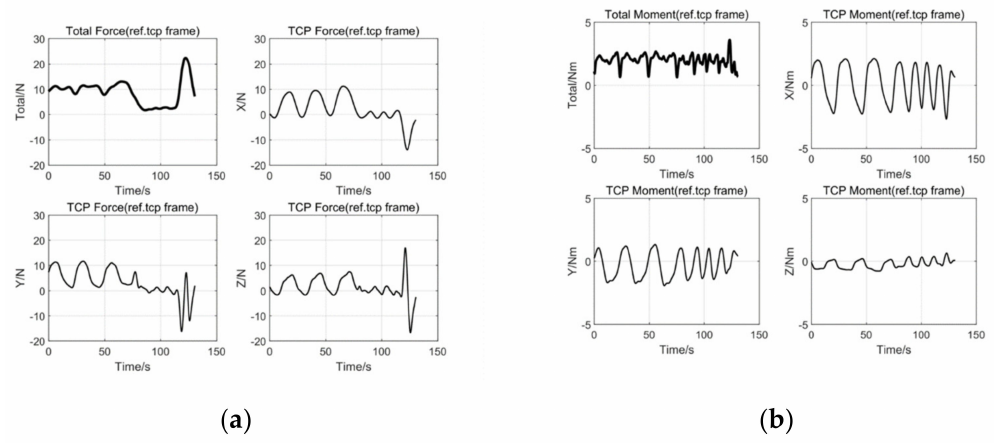
Figure 15. The interaction force and moment between the handle and the subject’s hand. ( a ) is the interaction force between the handle and subject’s hand; ( b ) is the moment between the handle and subject’s hand.